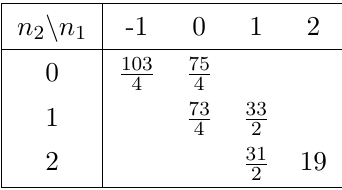
Table 8 . The quantity (cid:31)= 24 entering the D3 brane